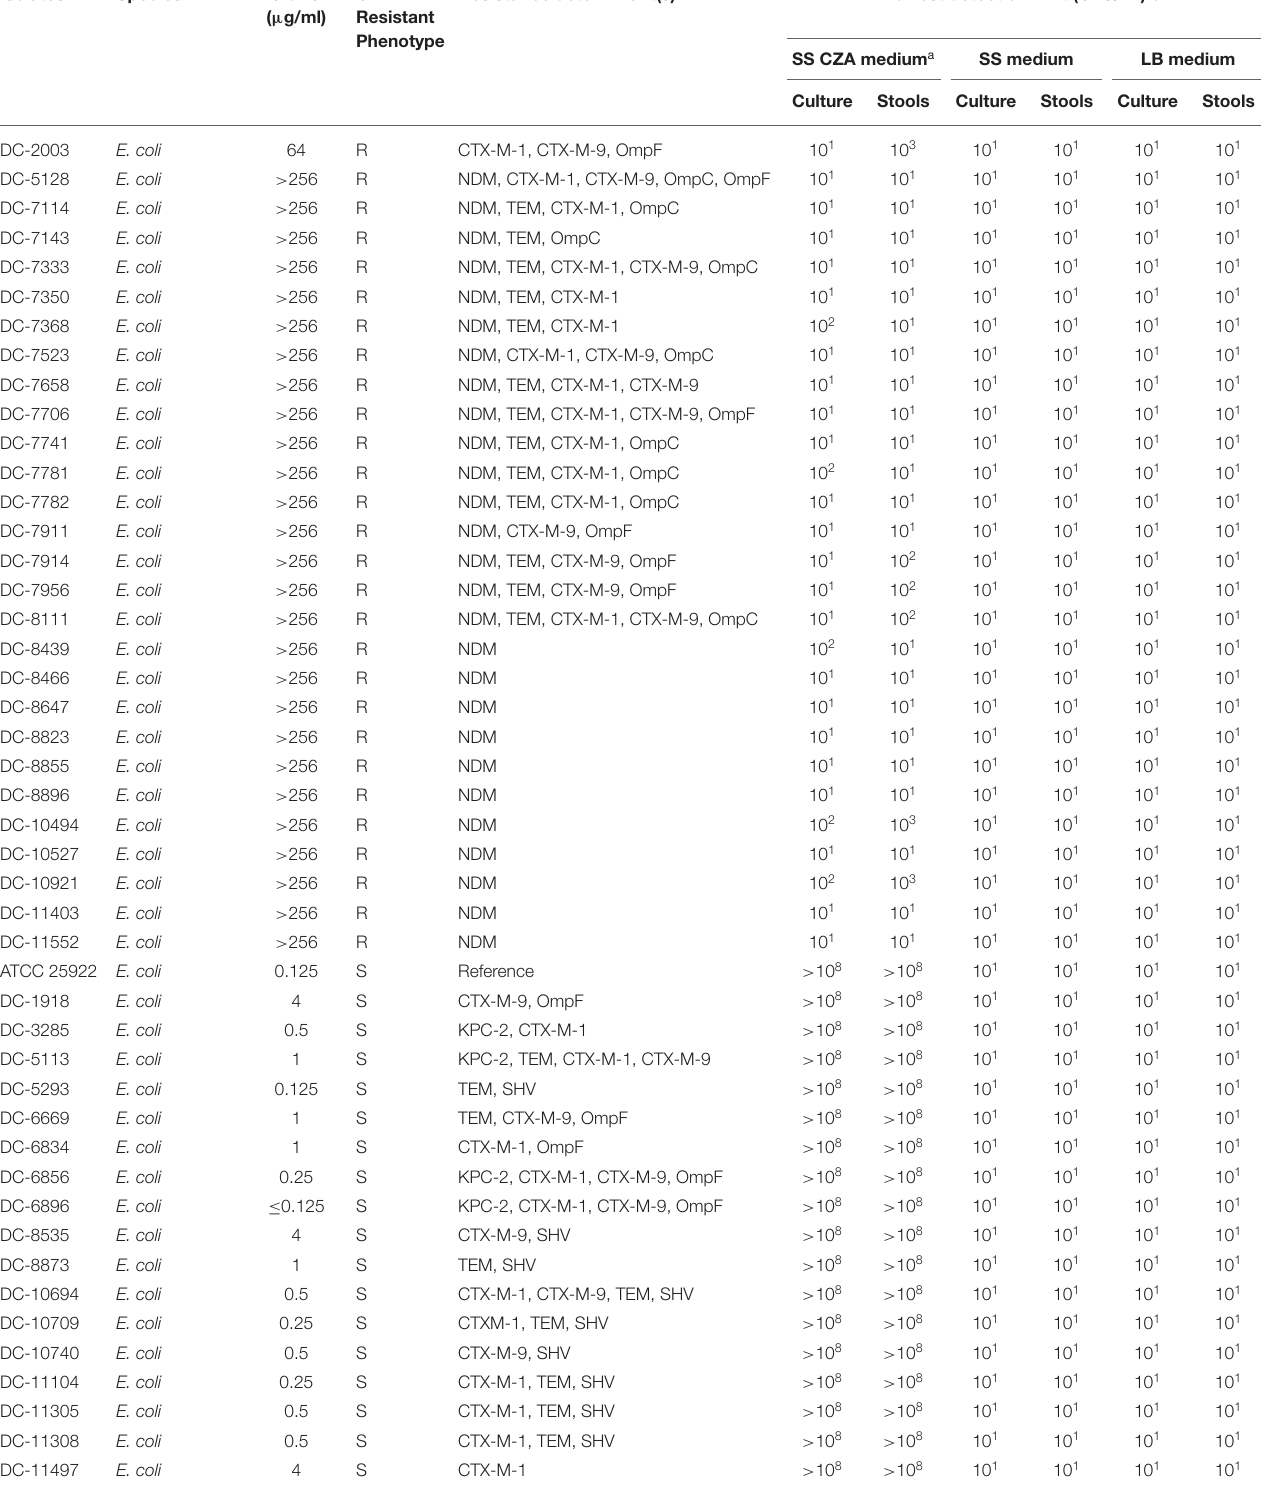
TABLE 2 | Summary of MIC values of the CZA for the tested isolates and the lowest detection limits of the SS CZA medium, SS medium, and LB medium. Isolates Species